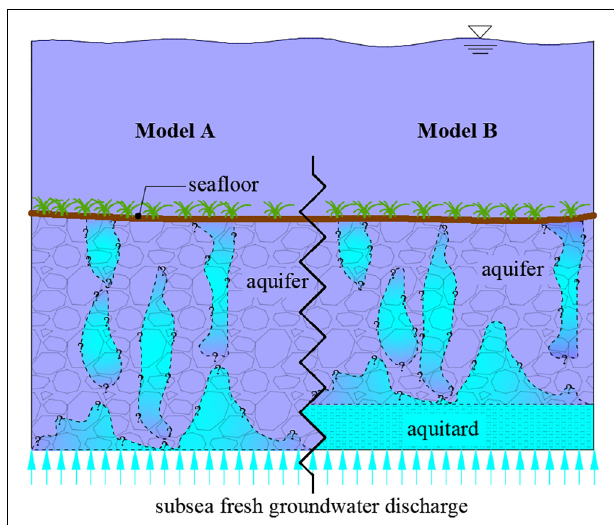
FIGURE 1 | Two conceptual models of a subsea unconfined aquifer subject to SFGD. Blue is freshwater, and purple is seawater. Model A (left) involves sandy sediments overlying a subcropping, higher-permeability aquifer, and Model B represents an aquitard overlain by